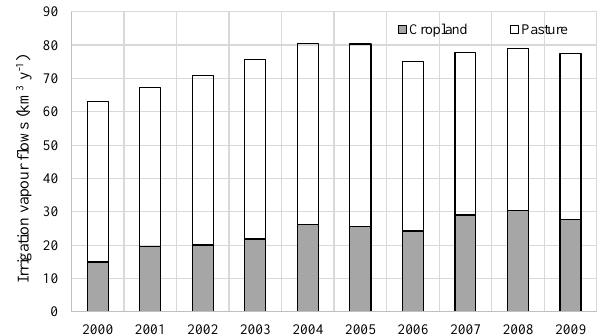
Figure 2. Annual irrigation requirements for cropland (as the sum of soybean, maize, cotton, and sugar cane) and pasture in south- eastern Amazonia (Mato Grosso) for the 2000–2009